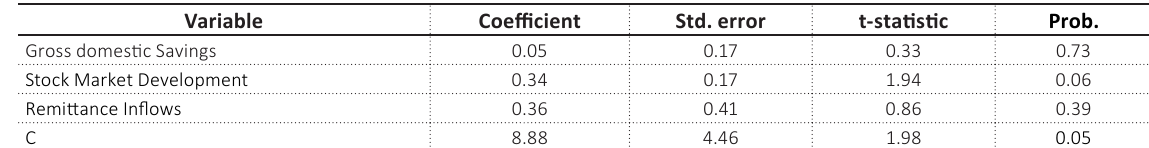
Table 5. Long-run coefficients for private sector credit and growth finance indicators